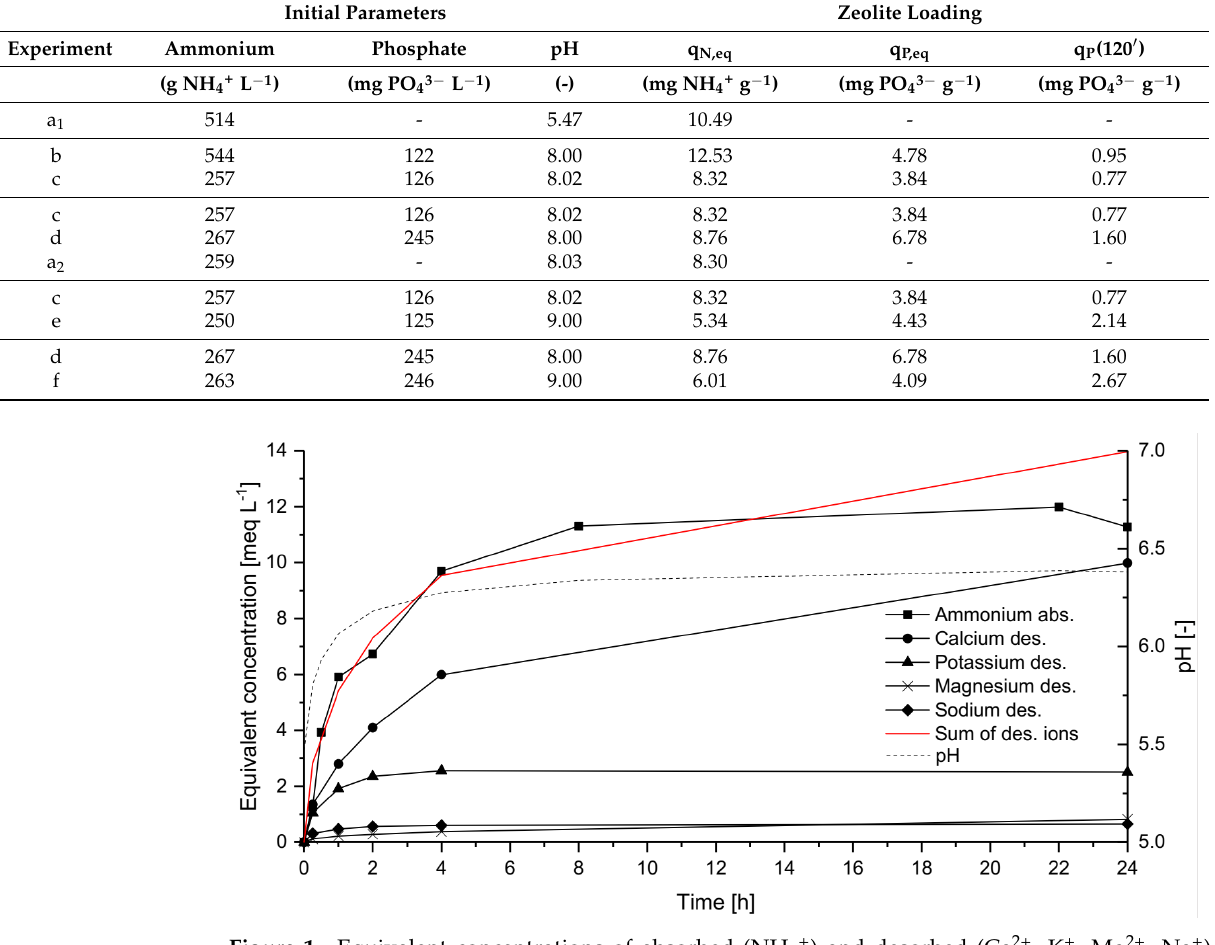
Figure 1. Equivalent concentrations of absorbed (NH 4 + ) and desorbed (Ca 2+ , K + , Mg 2+ , Na + ) cations over time. Line of absorbed ammonium is shown as the exchanged amount of equivalent concentration. Initial concentration: 514 mg NH 4 + L − 1